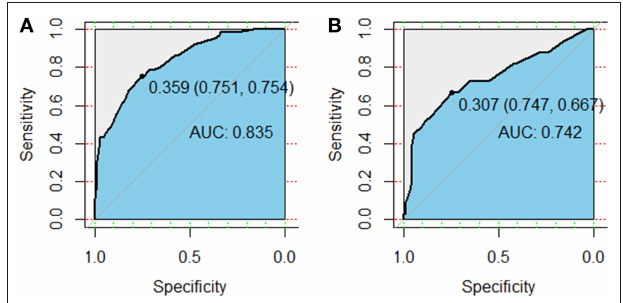
FIGURE 3 | Receiver operator characteristic (ROC) curves for the model predicting grade ≥ 2 radiation pneumonitis on 10-fold cross-validation (A) and the external validation set (B) .